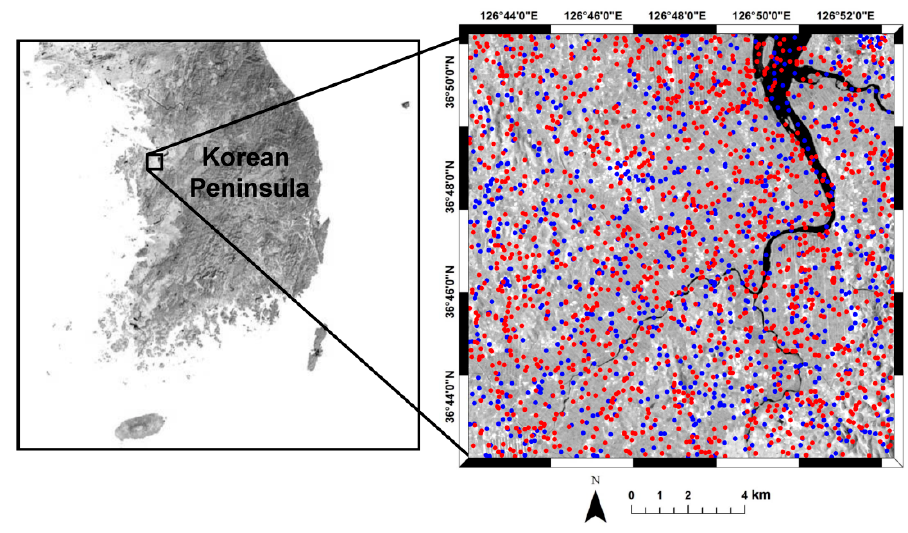
Figure 1. Location of the study area and the Radarsat-1 average backscattering coefficient image with training data (red dots) and reference data (blue dots).